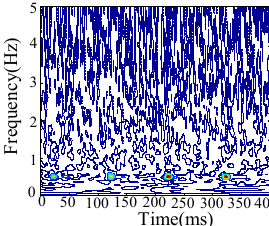
Figure 13. Time frequency reassignment distribution for the simulation signal.